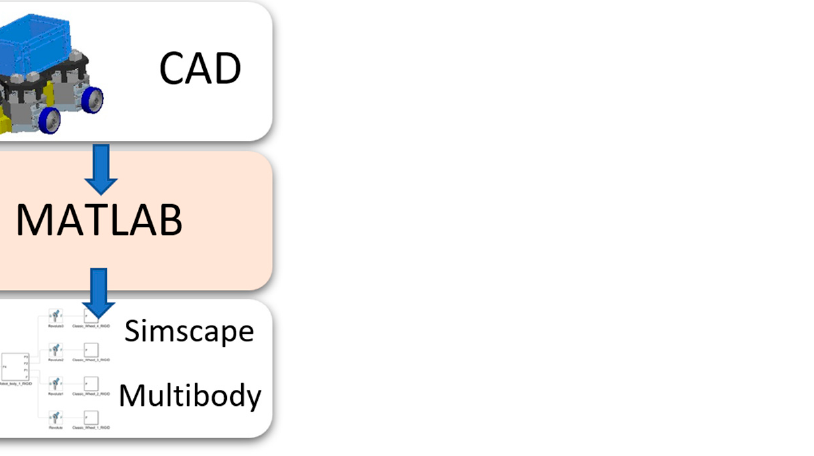
Figure 22. The connection between the 3D CAD model and Simulink–Simscape–Multibody.